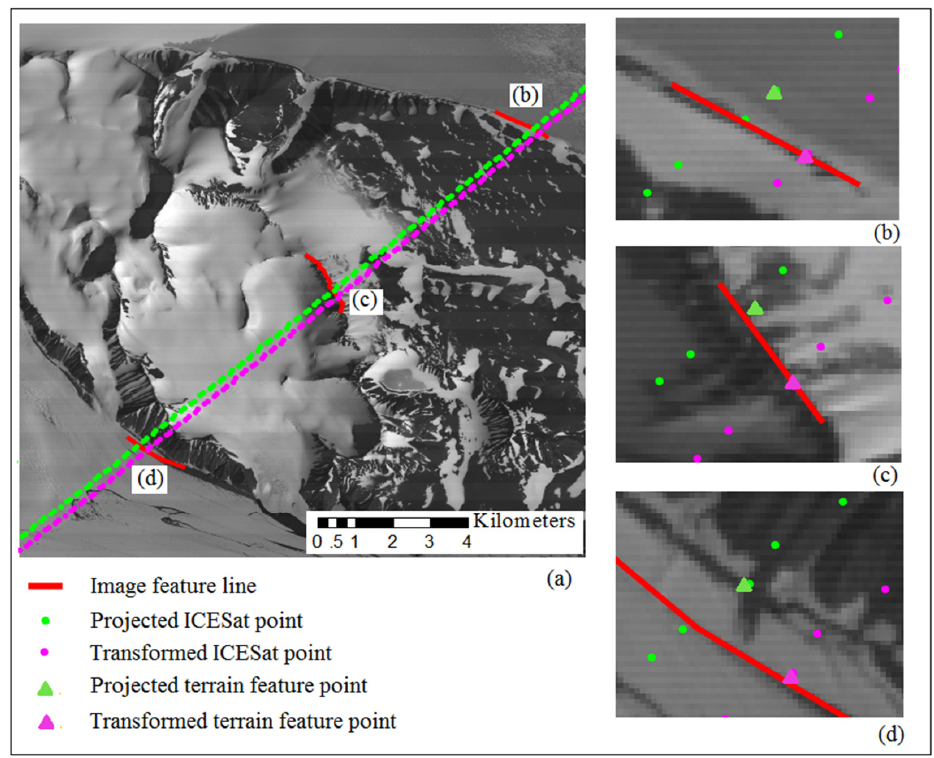
Figure 7. Discrepancies between the projected ICESat terrain feature points and the corresponding feature lines in the ASTER image before and after registration.